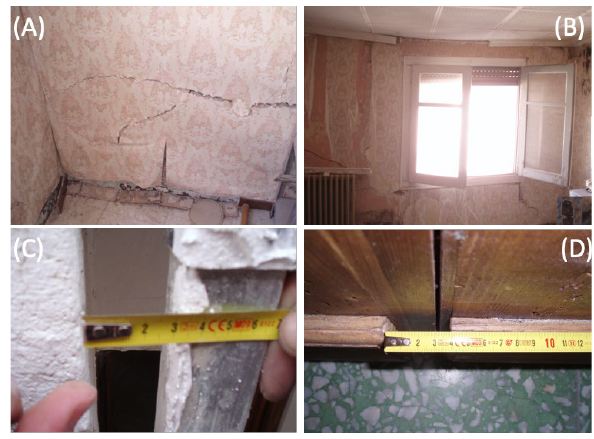
Figure 8. View of pathologies inside a Perdiguera building (6 Del Medio Street): (A) Wall cracks in the living room; (B) Cracks and deformation in a bedroom window; (C) Opening and deformation of a pile (3 cm); (D) Opening and deformation of the front door (4 cm).